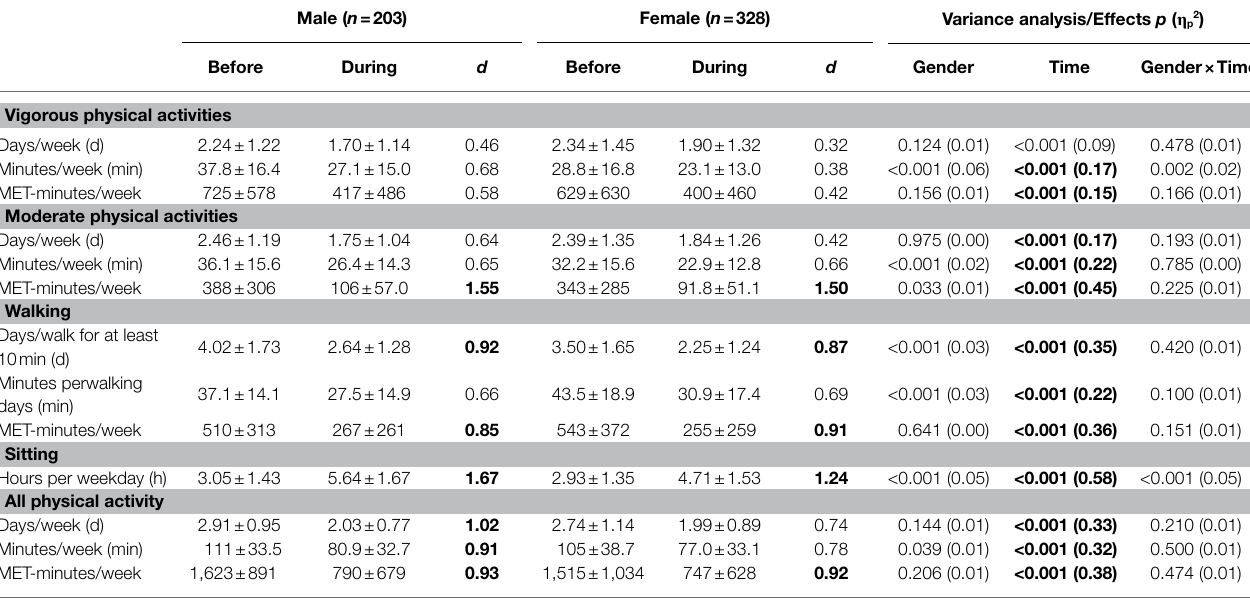
TABLE 3 | Comparison of physical activity parameters and sedentary behavior (sitting time) between males and females before and during confinement.